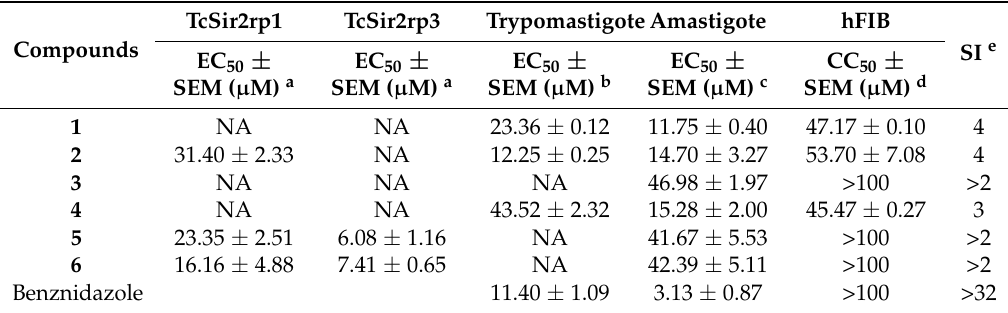
Table 1. Deacetylase (TcSir2rp1 and TcSir2rp3) and antiparasitic activity in trypomastigote, intracellular parasite, host cell cytotoxicity, and selectivity index of Anacardium occidentale chemical compounds.